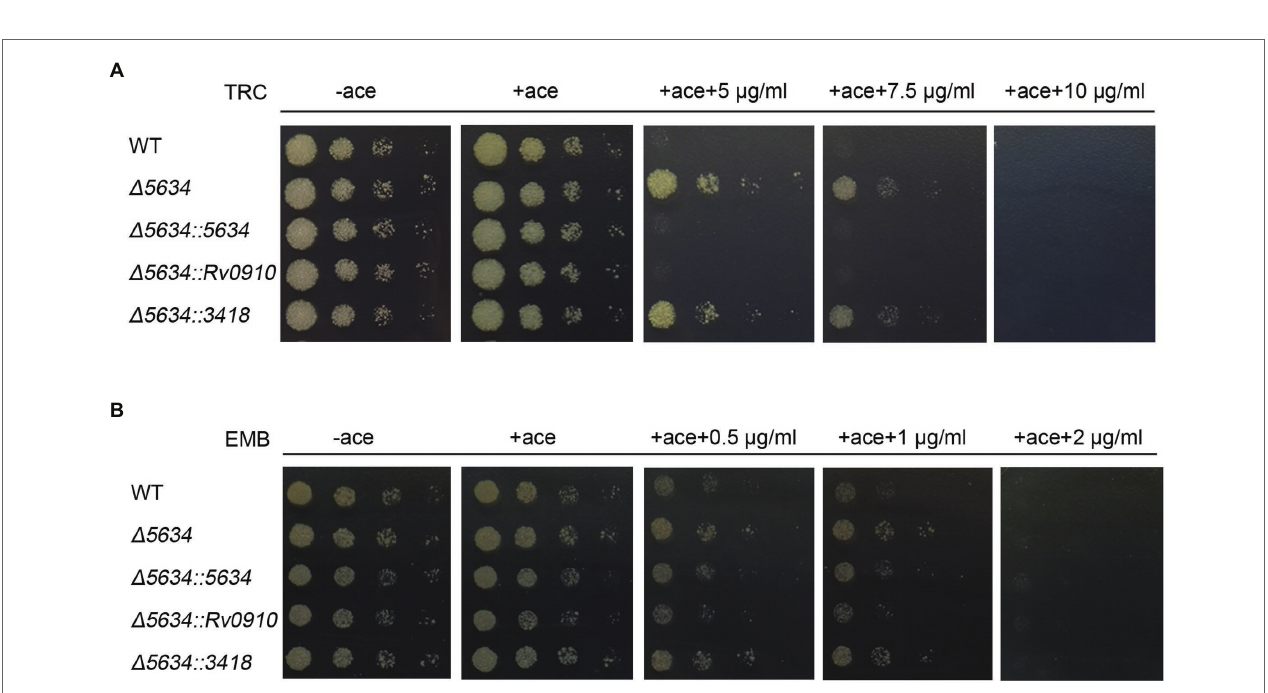
FIGURE 6 | vector; Δ 5634::5634 , Δ 5634::Rv0910 and Δ 5634::3418 are the MSMEG_5634 gene-deleted cells with the ectopic expression of MSMEG_5634, Rv0910, MSMEG_3418, respectively, under the control of the inducible acetamidase promoter in the pACE vector; Δ 5634:: Δ YHEW and Δ 5634::W30A are the MSMEG_5634 -deleted cells with the ectopic expression of the indicated MSMEG_5634 mutant in the presence of acetamide (ace, 0.2%); and WT ::5634 and WT ::Rv0910 are the wild-type cells with the ectopic expression of MSMEG_5634, and Rv0910, respectively, under the control of the inducible acetamidase promoter in the pACE vector.